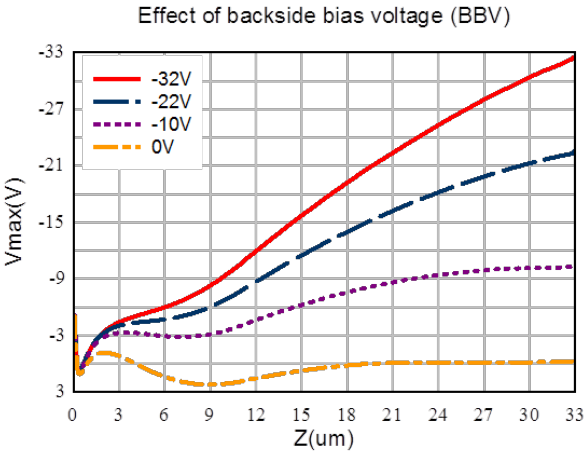
Figure 12. Potential profiles in z-direction at the center vs . backside voltage.